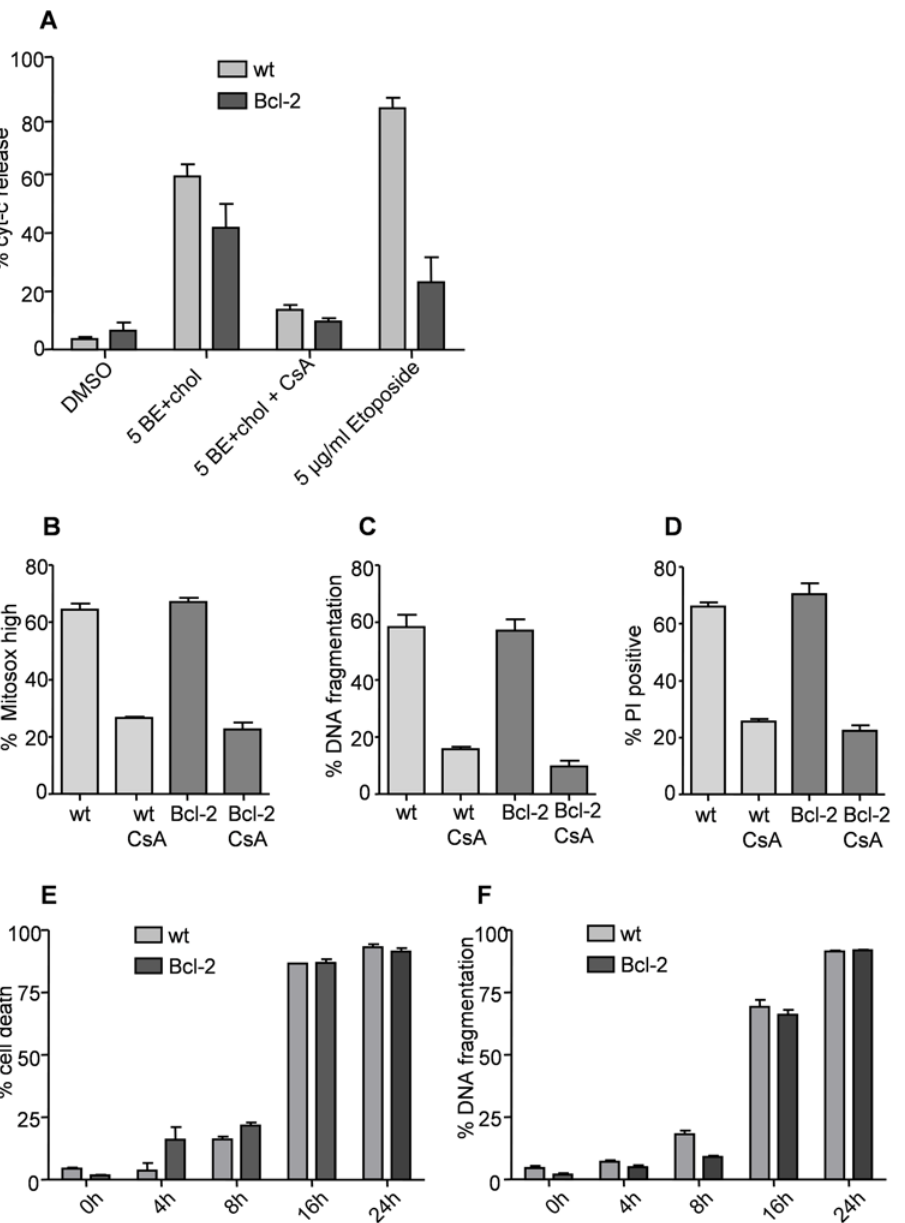
Figure 4. BE/cholesterol induced apoptosis is not affected by Bcl-2 over-expression but is inhibited in the presence of cyclosporin A. (A) Jurkat control (wt) or Bcl-2 over-expressing cells (Bcl-2) were treated as indicated (5BE=5 m g/ml BE; chol=5 m M cholesterol; CsA=5 m g/ml cyclosporin A), after 24 hours intracellular staining for cytochrome c release was performed. (B, C, D) Jurkat control (wt) or Bcl-2 over-expressing cells were treated with 5 m g/ml BE/ 5 m M cholesterol either in the absence or presence of 5 m g/ml cyclosporin A. After 24 hours ROS (B), DNA fragmentation (C) and overall cell death (D) were assessed by FACS analysis. (E, F) Jurkat control (wt) or Bcl-2 over-expressing cells were treated with 5 m g/ml BE/ 5 m M cholesterol and PI exclusion (E) or DNA fragmentation (F) were measured after 0, 4, 8, 16 and 24